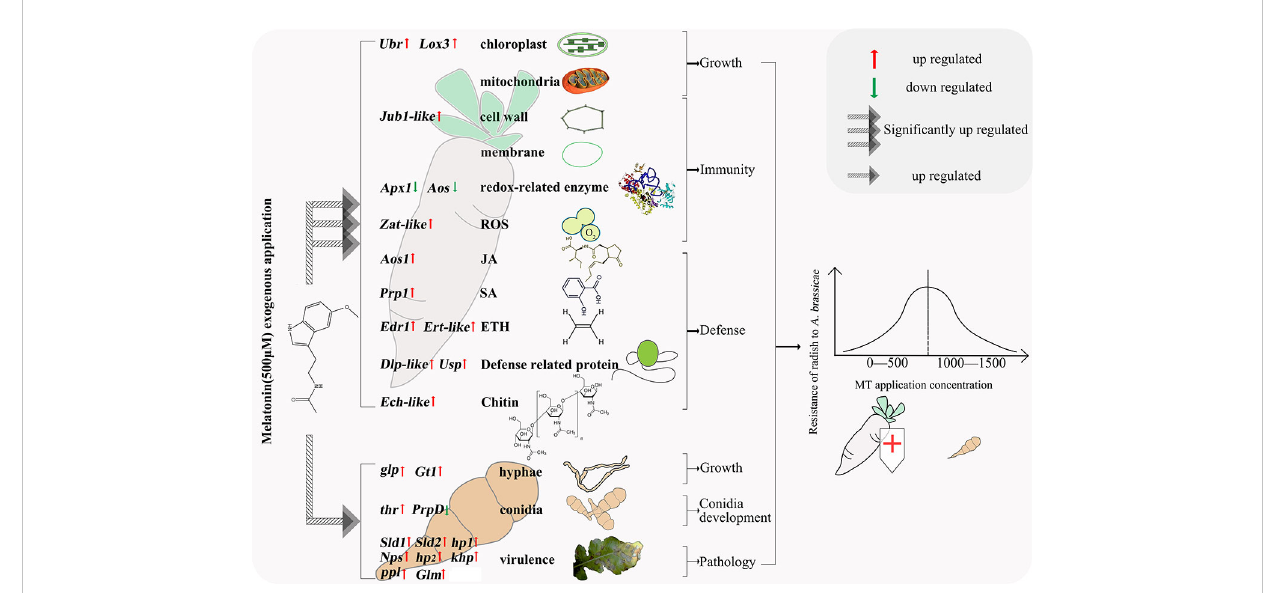
FIGURE 8 Molecular mechanisms of radish resistance to A. brassicae affected by exogenous